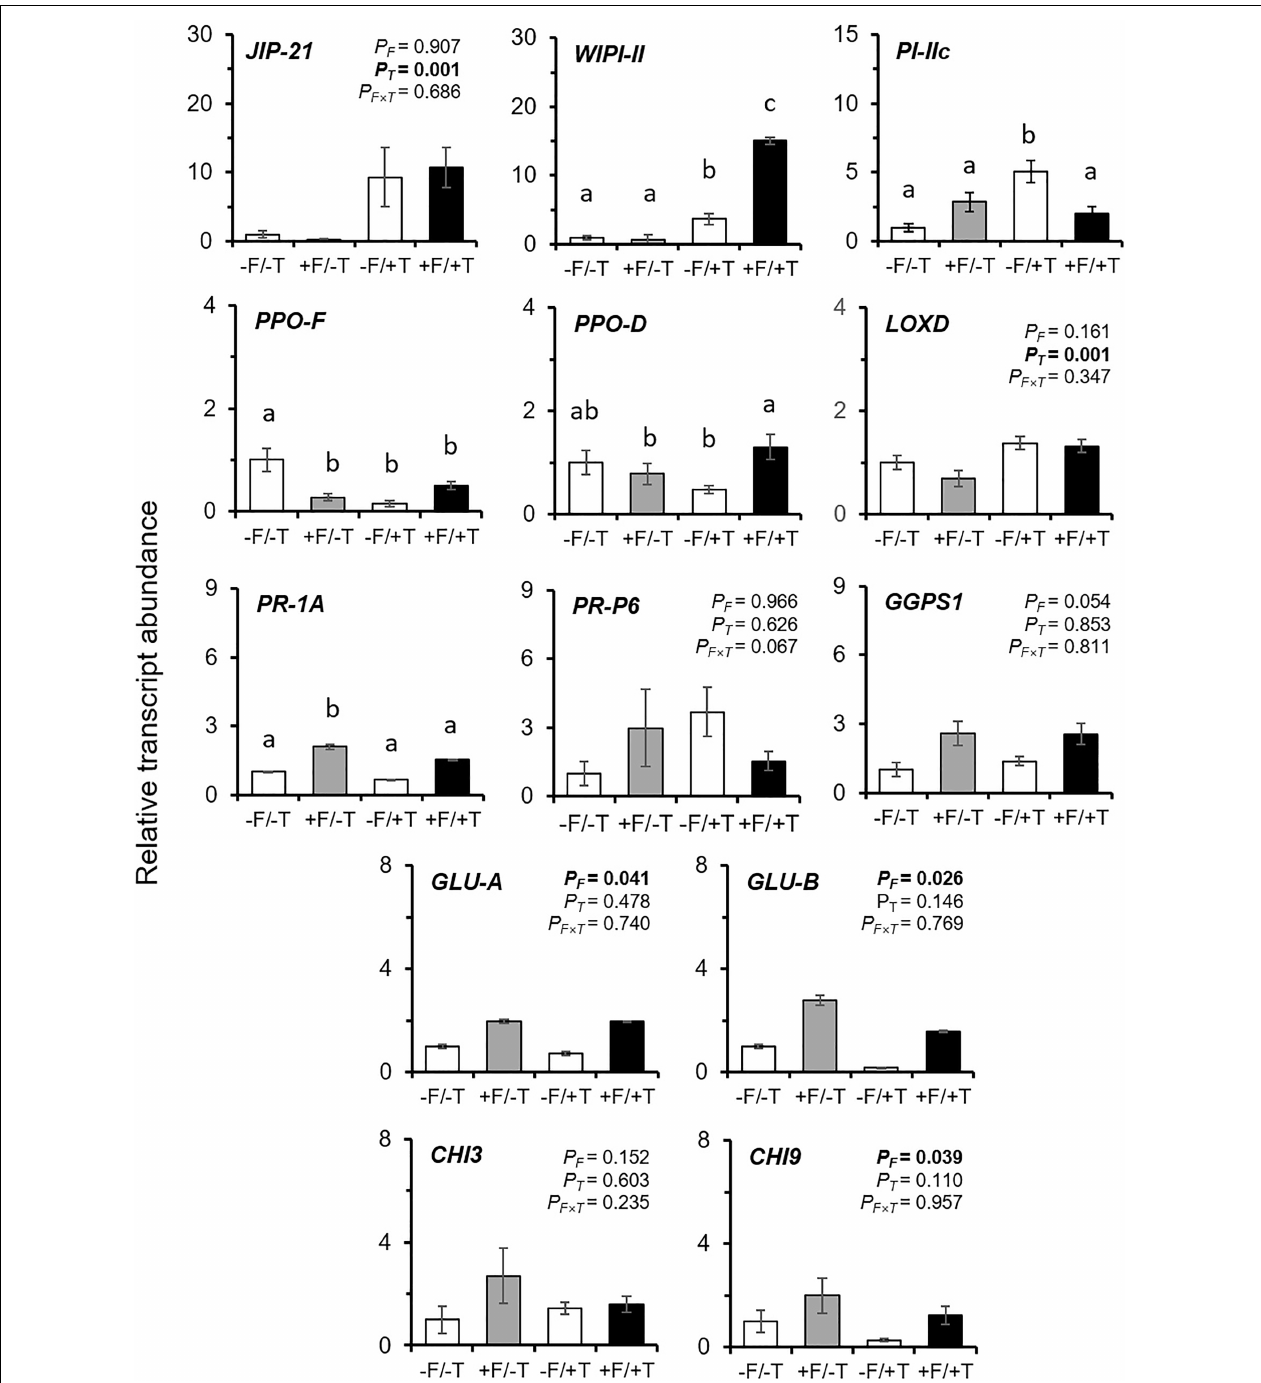
FIGURE 4 | Effects on the transcript levels of defense marker genes in tomato plants colonized by the endophyte F. solani strain K (+F) and/or infested with spider mites ( T. urticae , +T) compared with the untreated control (–F/–T). Values are the average ± SE of two technical replicates for each of six biological replicates of an independent experiment ( Supplementary Table S2 ). Expression levels for all target genes were normalized to the geometric mean of ubiquitin and actin expression levels in each sample as a reference. Two-way ANOVA ( α = 0.05) P -values are shown for each gene on each panel in the case of non-significant interaction effects ( P F ∗ T > 0.05) and significant P -values ( < 0.05) are indicated in bold: P F , probability value for the endophyte (FsK) effect; P T , probability value for the herbivore (T) effect; P F ∗ T , probability value for FsK × T interaction. In the case of significant interaction ( P F ∗ T < 0.05) significant differences between treatments are indicated by different letters by Tukey’s post hoc tests after two-way ANOVA: P < 0.05. JIP-21 , WIPI-II , PI-IIc , PPO-F/D, and LOXD are JA-marker genes; PR-1A and PR-P6 are SA-marker genes; GLU-A/B and CHI3/9 are fungal (or herbivore, e.g., whitefly)-marker genes; GGPS1 has been reported as responsive to spider mite infestation in tomato (see relevant references in manuscript).